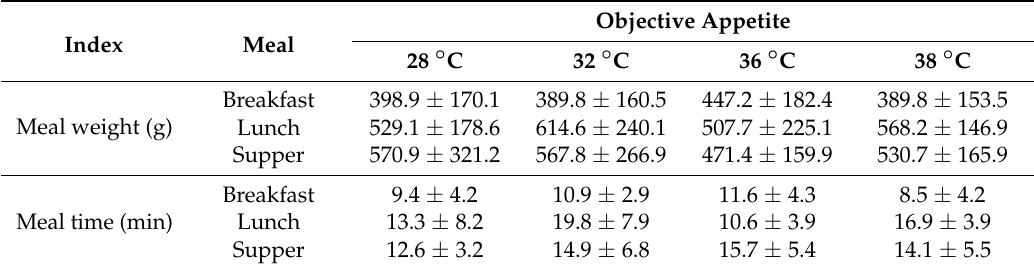
Table 5. The objective appetite in the four temperature